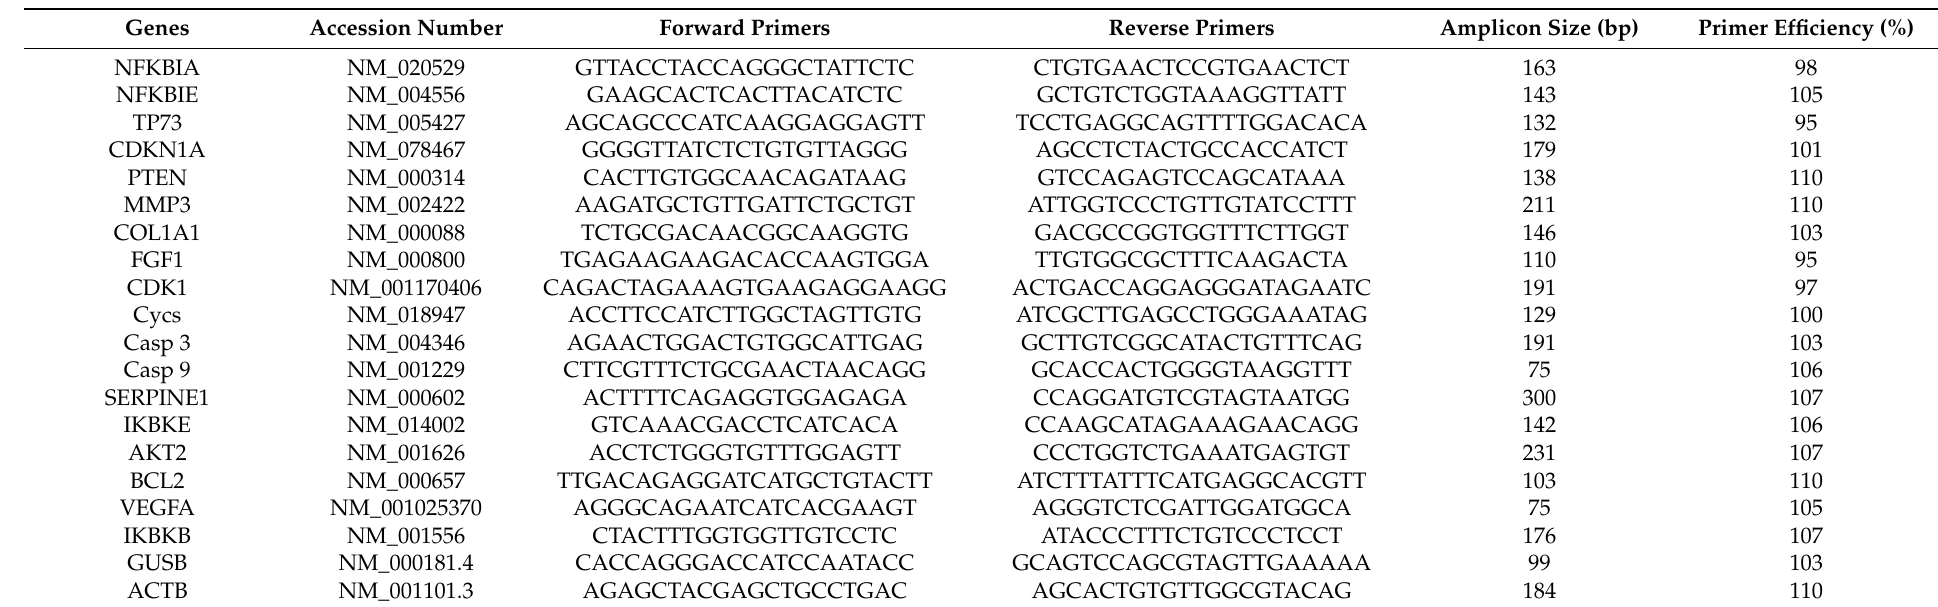
Table A1. The primer sequence used in quantitative real-time PCR (qPCR)